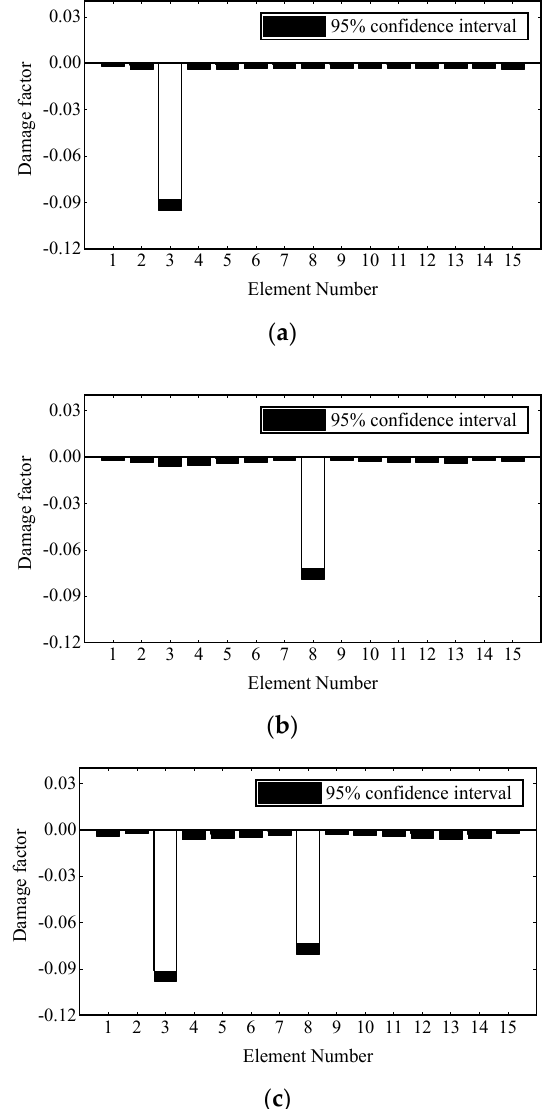
Figure 6. Damage identification results under 5% noise: ( a ) scenario 1; ( b ) scenario 2; ( c ) scenario 3.